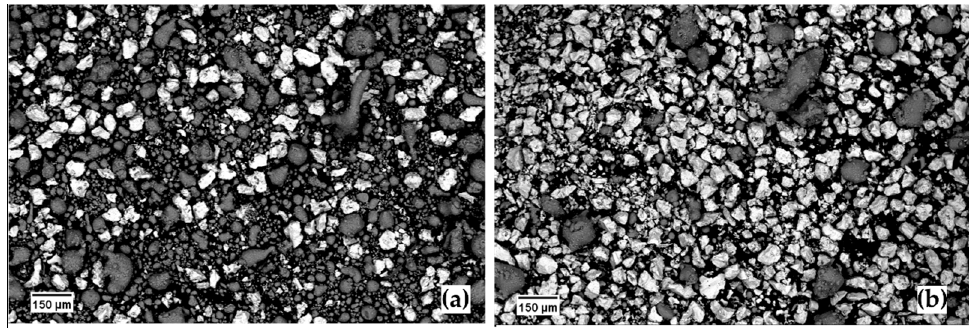
Figure 2. SEM micrograph of the two batches of powders after manual mixing ( a ) 20Ti-AlSi; ( b )